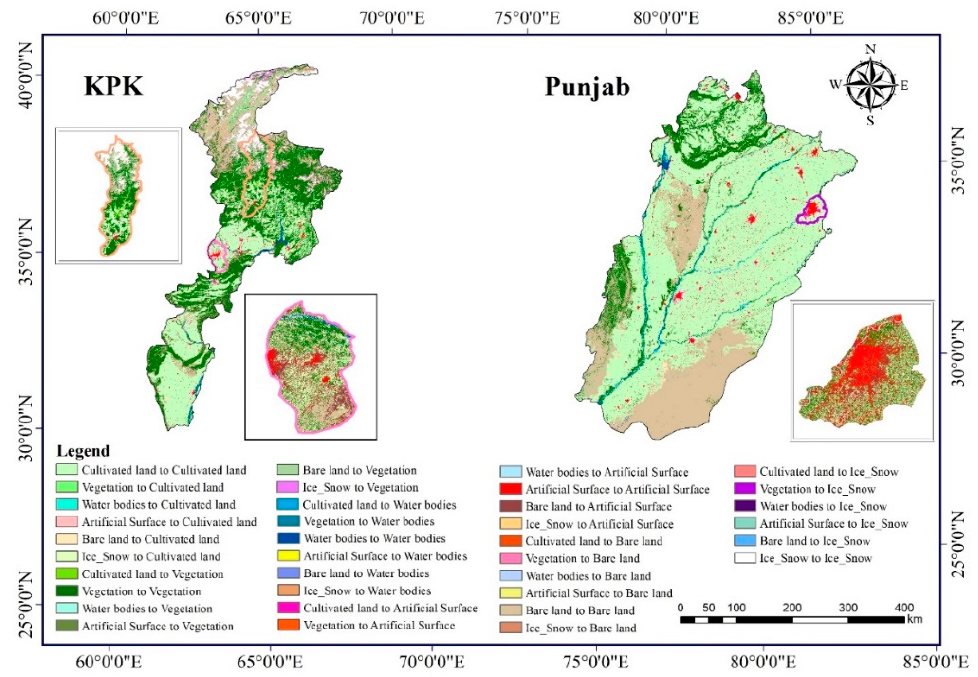
Figure 4. The LULC transition categories for KPK ( Left ) and Punjab ( right ) from 2000 to 2020. Table 3. LULC transitions in KPK and Punjab province between 2000 and 2020 (area in sq.